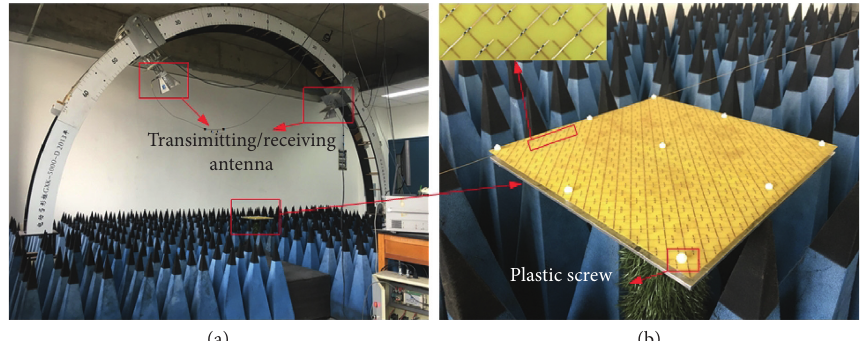
Figure 8: (a) Reflection measurement setup and (b) photograph of the